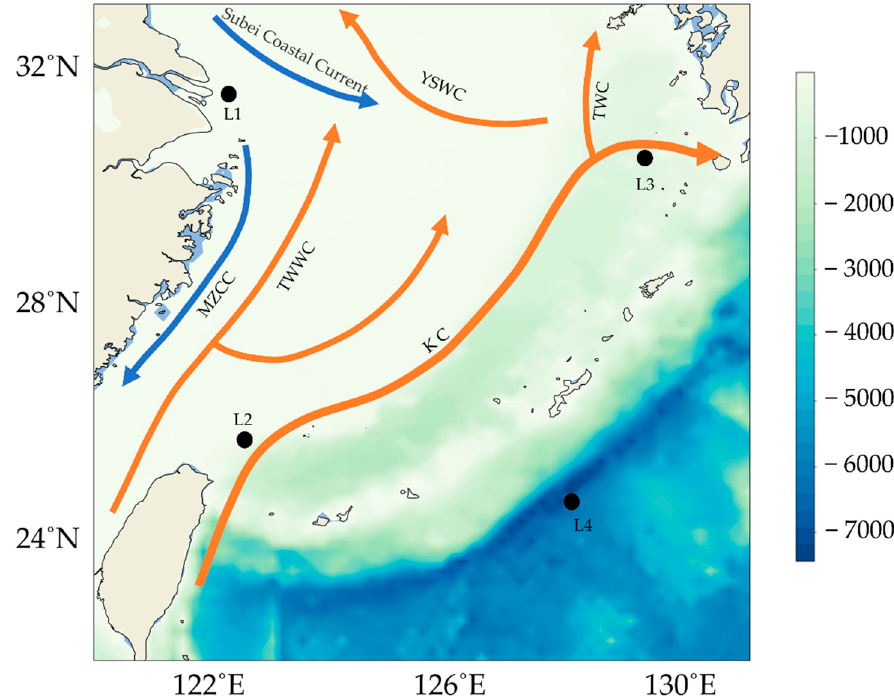
Figure 3. Location diagram of different points. The black dots represent the selected positions. MZCC, TWWC, YSWC, TWC, and KC represent the Min-Zhe Costal Current (Min is Fujian province, Zhe is Zhejiang Province), the Taiwan Warm Current, the Yellow Sea Warm Current, the Tsushima Warm Current, and the Kuroshio, respectively. Besides the blue line is the cold current, and the red line is the warm current and the unit of colorbar is meters.